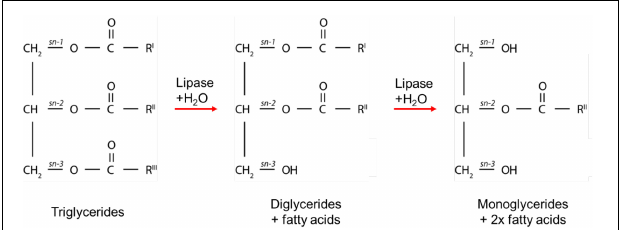
FIGURE 1 | A schematic diagram of the digestion process of triglycerides. R I , R II , and R III represent the alkyl chains that make up the triglycerides, which can comprise the same or different fatty acids. The combinations of alkyl chains are dependent on the source of fat.